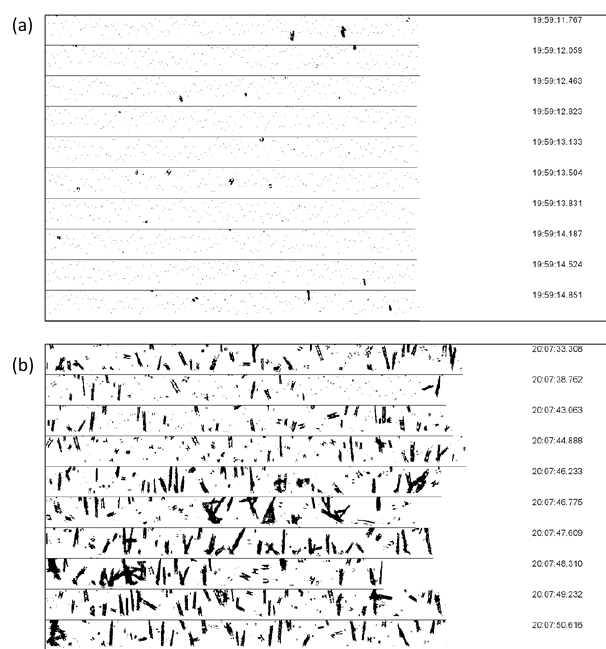
Fig. 9. 2-D CIP image examples taken during the active Hallett Mossop period of flight #104. (a) – for the low ice concentration pe- riod, 19:59:11 to 19:59:15, ( T = − 2 ◦ C); (b) – for the high ice con- centration period, 20:07:33 to 20:07:50, ( T = − 2 ◦ C). The times- tamps are as in Fig.